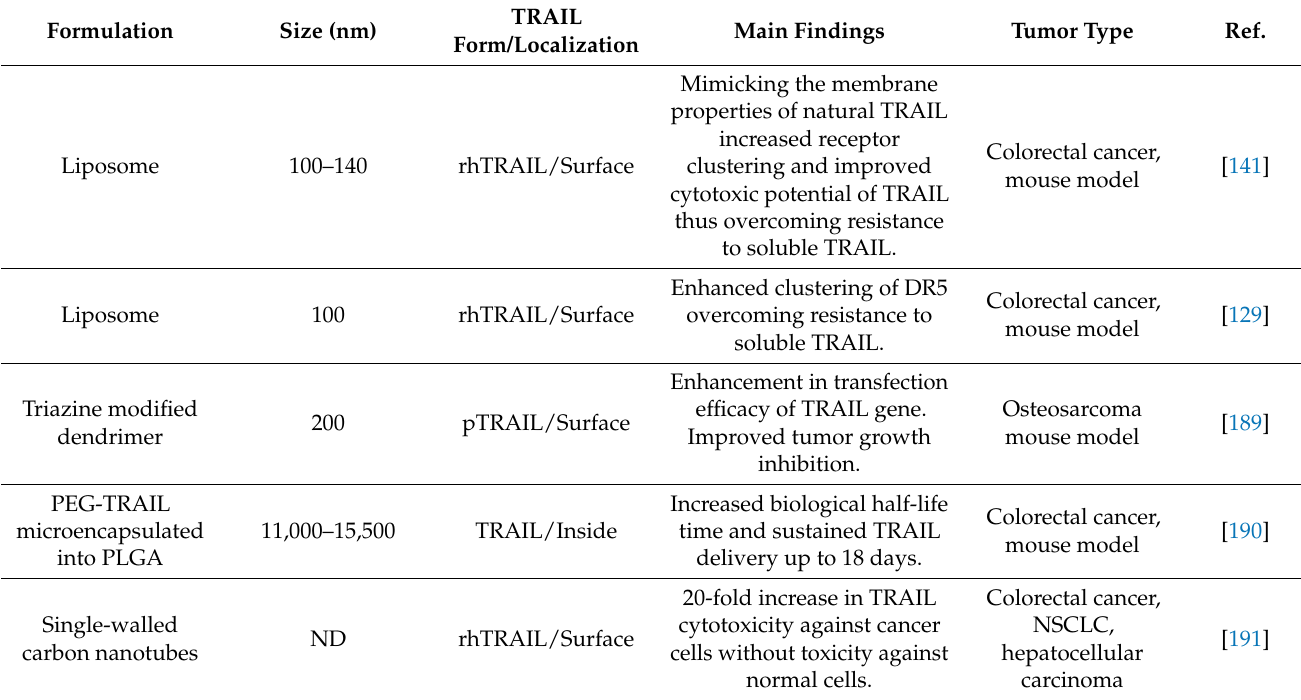
Table 1. Nanoformulations used for passive TRAIL